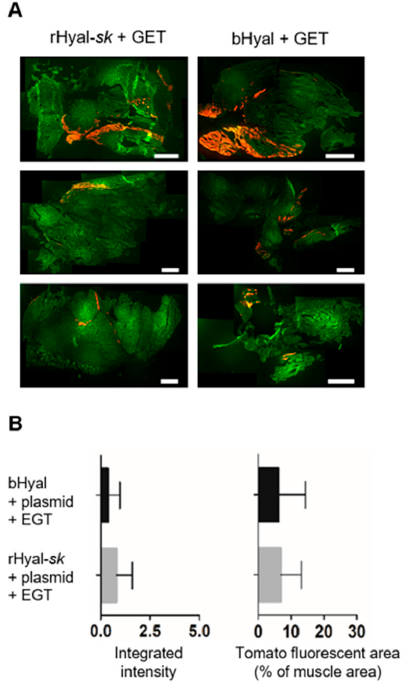
Figure 1. Transfection efficiency of the combination plasmid GET plus rHyal ‐ sk . ( A ) Representative rHyal- sk or bHyal. Fluorescence images (Red: tdTomato, Green: tissue autofluorescence) were acquired on a Macroscope after mounting. 5 × magnification. Scale bars, 1 mm. ( B ) Fluorescence integrated (n = 4 muscles) or bHyal (n = 4 muscles). Data are Mean ± SD, p = 0.63 and 0.95 respectively (n.s.). Statistical analysis: Mann Whitney